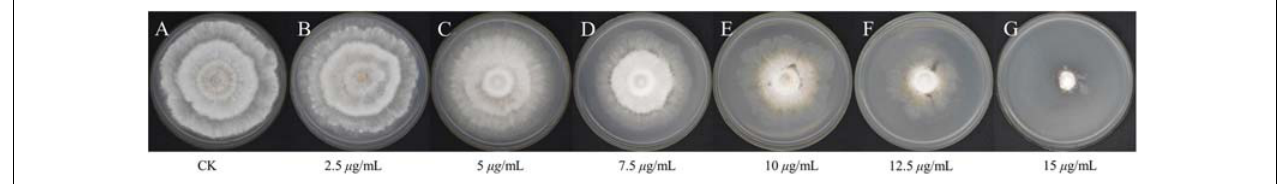
Frontiers in Microbiology |